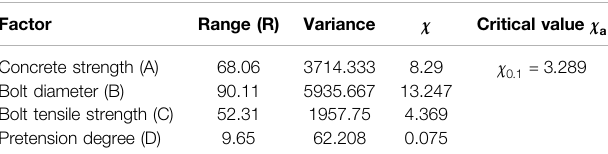
TABLE 6 | Range and variance analysis results of the ultimate capacity of